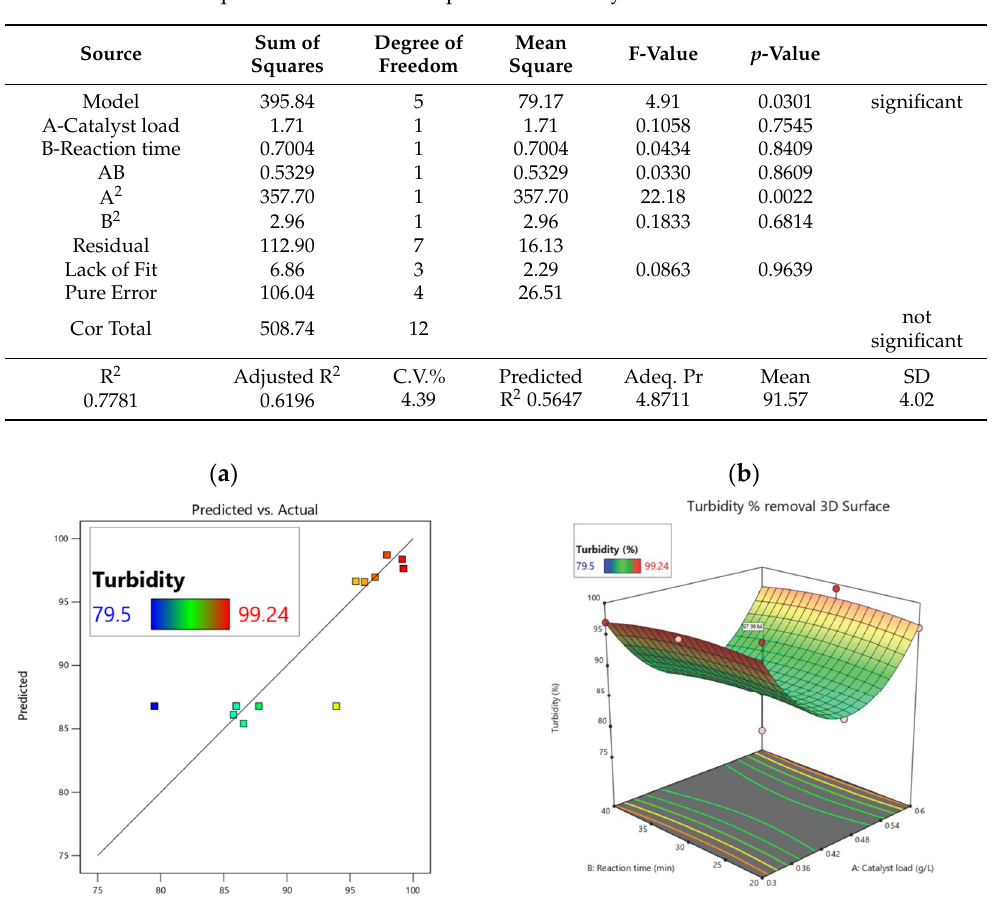
Figure 5. ( a ) Predicted vs. actual values of turbidity removal; ( b ) 3D surface plot of turbidity removal.